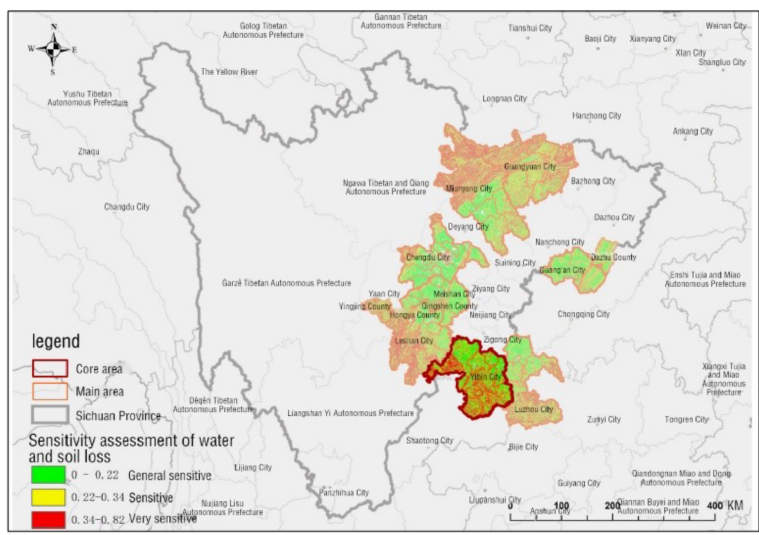
Figure 13. Sensitivity assessment of water and soil loss in research areas of Sichuan Province.